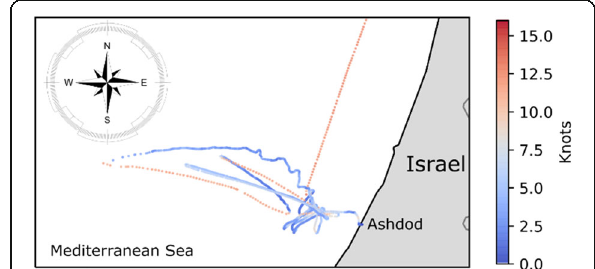
Fig. 1 Trajectory of the ship MSC Lausanne on its arrival at Ashdod (January, 2018). The lack of ship-port synchronization led to two days of delay, consumption and GHG emissions. The colors show the variations in speed on the different attempts of entering at the